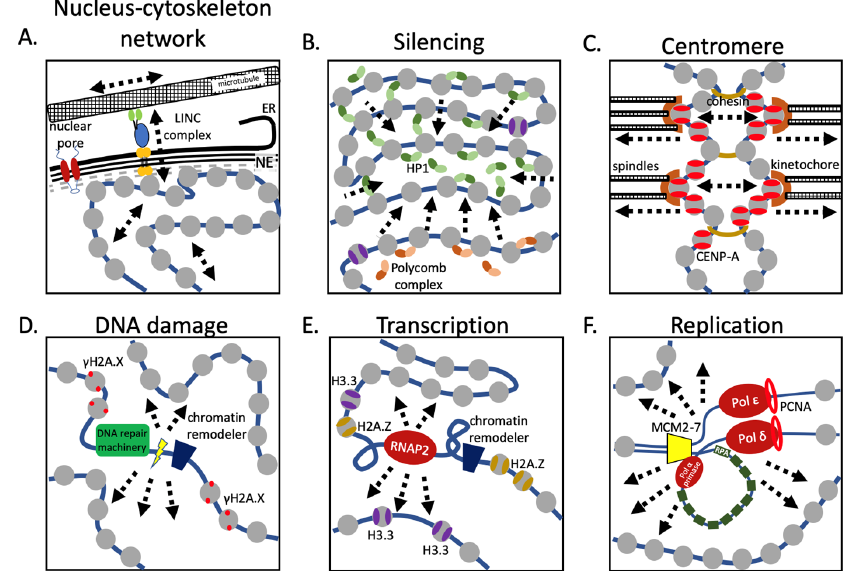
Figure 3. Nuclear machinery alter chromatin properties. ( A ) Physical forces are transmitted to the chromatin through a trans-nuclear envelope protein complex, altering both chromatin compaction and gene transcription. ( B ) Gene repression is commonly achieved through heterochromatin formation by either HP1 or Polycomb complexes, resulting in chromatin condensation and reduced chromatin elasticity. ( C ) Mitosis is a highly physical event, where in a highly coordinated manner, chromosomes are moved over extensive distances through the mitotic spindle machinery. The pushing and pulling forces that are excepted on the chromosomes, and especially the centromeric chromatin, are critical in satisfying the spindle checkpoint. ( D ) DNA damage must be repaired as quickly as possible, recruiting the DNA repair machinery, and locally decondensing chromatin, temporarily altering the local chromatin dynamics in part by enrichment of phosphorylated H2A.X nucleosomes. ( E ) Gene transcription is one of the most profound events in the nucleus, where the transcriptional machinery distorts the DNA double helix both behind and in front of the RNA polymerase. Highly transcribed regions are also enriched for H2A.Z and H3.3 nucleosomes. These nucleosomes might alter the local chromatin properties, potentially bringing together distant sites, such as enhancers and promoters. ( F ) Replicating chromatin has to decondense for the replication machinery to pass through, while at the same time maintaining distinct chromatin marks to be present on both newly formed strands. This highly dynamic and local event might temporarily increase the chromatin’s elasticity. ER = endoplasmic reticulum, NE = nuclear envelope.